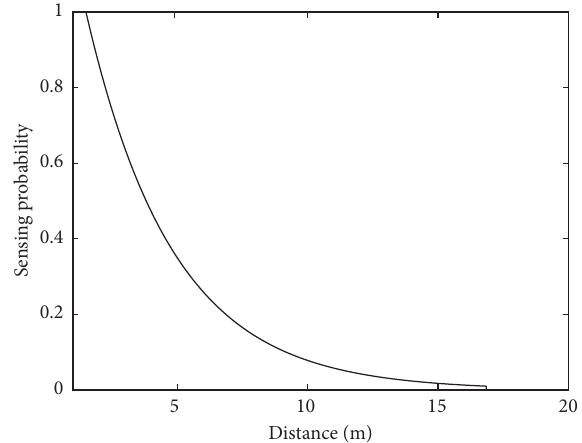
Figure 1: The relationship between sensing probability and dis- tance when α � 0.3.